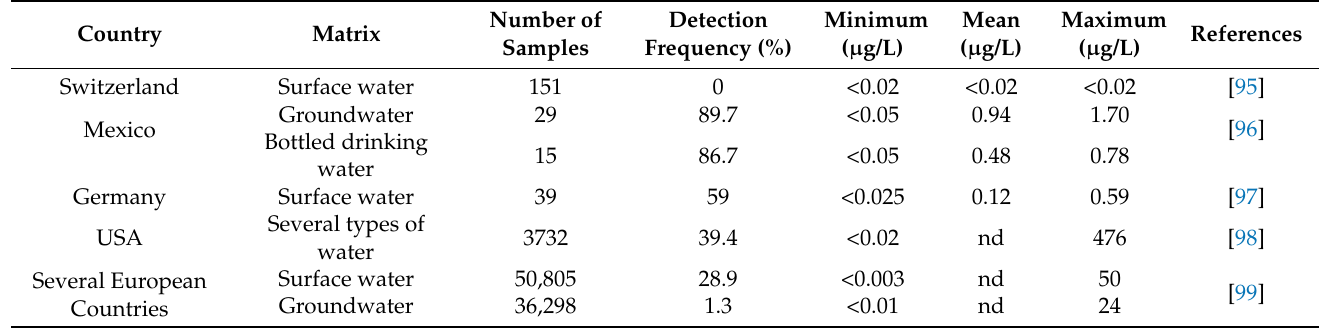
Table 10. Occurrence of glyphosate in water.